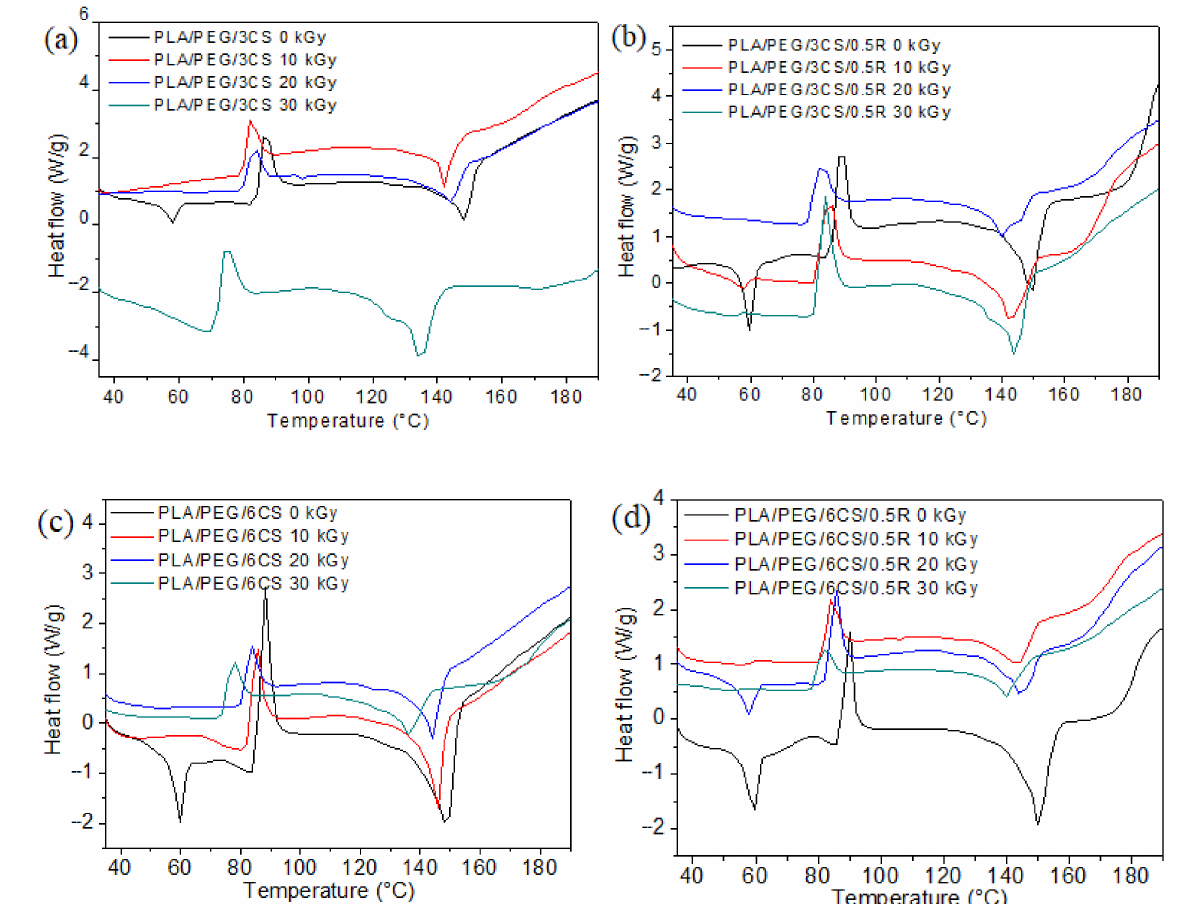
Figure 7. DSC curves for of PLA/PEG/3CS ( a ), PLA/PEG/3CS/0.5R ( b ), PLA/PEG/6CS ( c ), and PLA/PEG/6CS/0.5R ( d ) samples irradiated at 10, 20, and 30 kGy in comparison with non-irradiated samples. Recorded in the 2nd heating